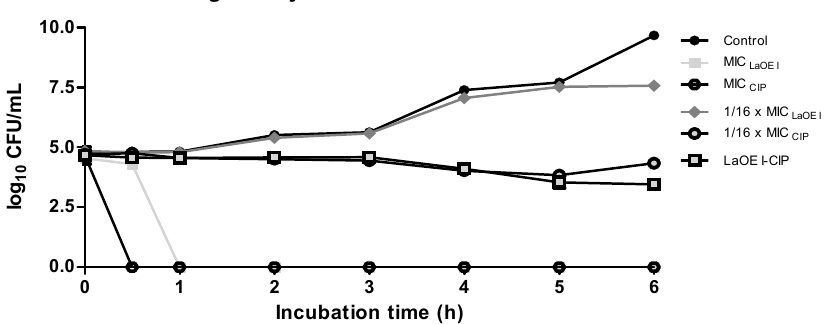
Figure 2. Effect of time of exposure to LaEO I and LaEO I-CIP association on the viability of Shigella dysenteriae ATCC 13313. Values are expressed as mean ± SEM of two assays. The analysis was performed by ANOVA, with Dunnett’s post-test and p value < 0.05 compared to the control. Control: culture medium + microorganism; MIC LaEO I = 1 mg/mL; MIC CIP = 0.25 μg/mL; FICI LaEO I-CIP = 0.125 (lowest concentrations of the LaEO I and CIP association, with antimicrobial activity = 1/16 x MIC).